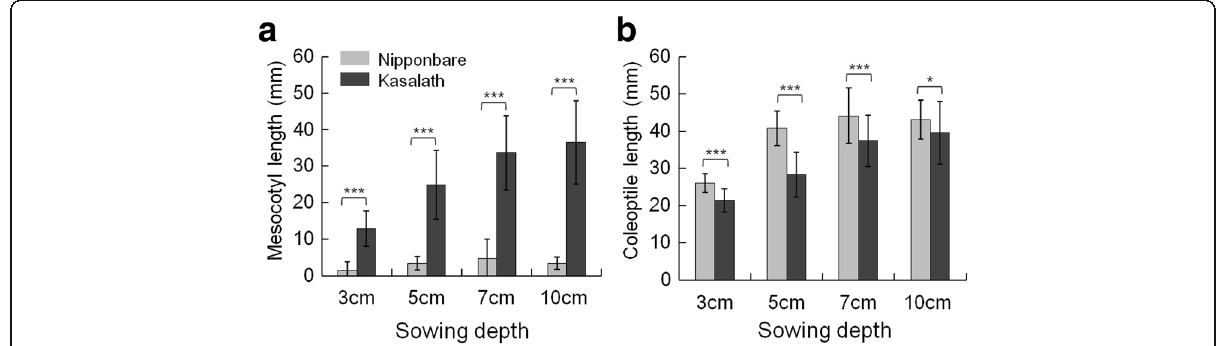
Fig. 1 Phenotypic variation of mesocotyl and coleoptile elongation at varying soil depths. a Mesocotyl and b coleoptile length of Nipponbare and Kasalath under different burial depth in soil; 12 Seeds of Nipponbare and Kasalath were sown at 3 cm, 5 cm, 7 cm, and 10 cm soil depth and incubated at alternate temperatures of 30 °C and 26 °C (14 h/10 h). At 14 days after sowing, the seedling were excavated and length were measured. Bars represent mean of length with SD ( n = 3). Comparisons of the varieties were made with the ANOVA test. * P < 0.05, *** P <